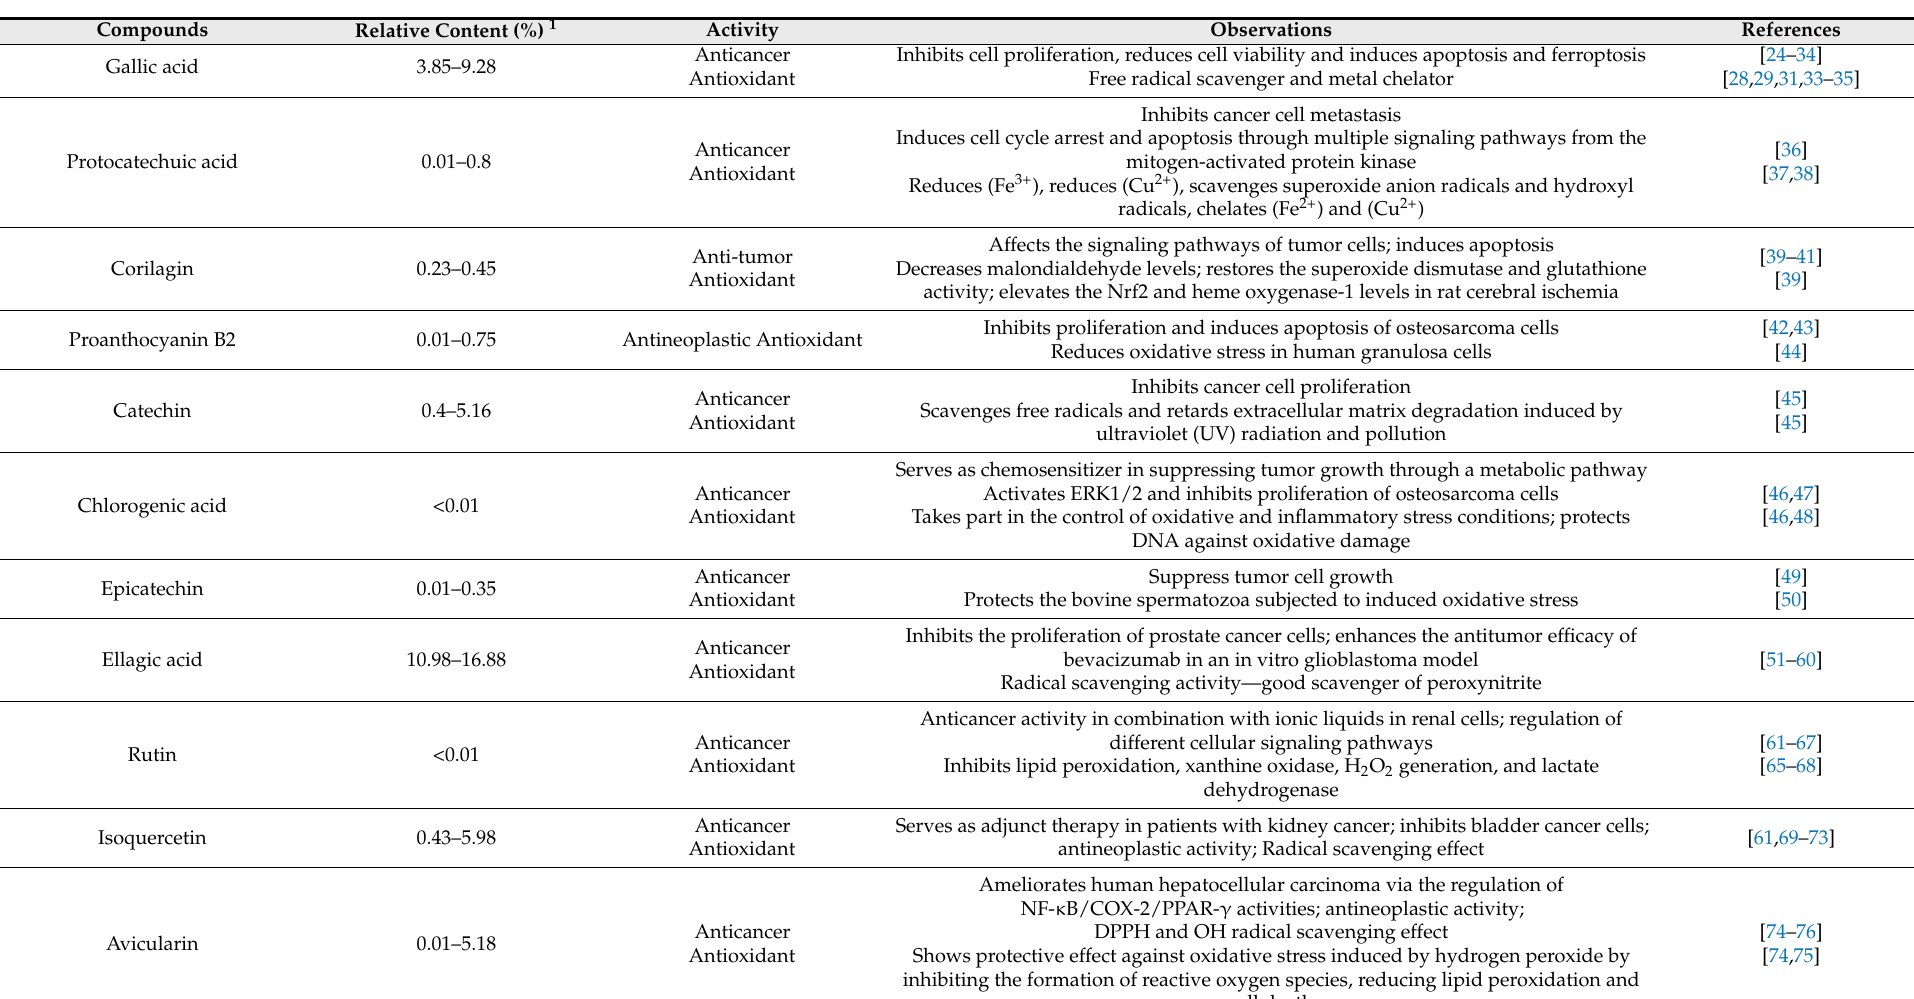
Table 1. Main compounds of wastewaters from Rosa damascena Mill., Rosa alba L., Rosa gallica L., and Rosa centifolia L., obtained by UHPLC-HRMS/MS analysis with clearly expressed healing, antineoplastic, and antioxidant